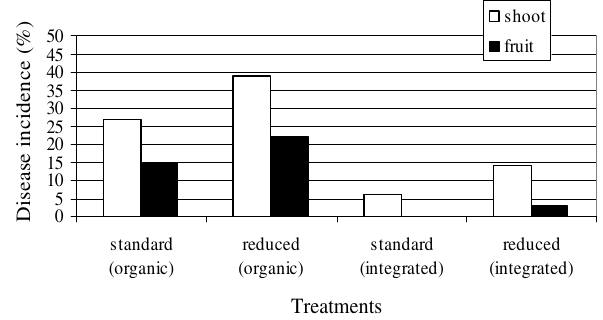
Figure 5. Efficacy of standard and reduced spray programmes on brown rot on shoot and fruit in integrated and organic sour cherry orchards in 2008 (LSD0 = 4.8 – integrated (shoot); LSD0.05 = 7.6 – organic (shoot); .05 LSD = 4.4 – organic (fruit)). 0.05 = 5.2). 0.05